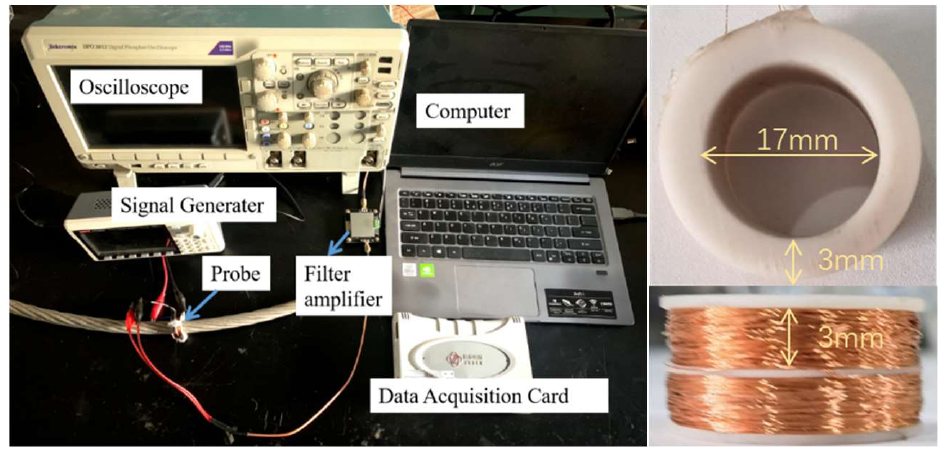
Figure 8. PEC experimental setup.